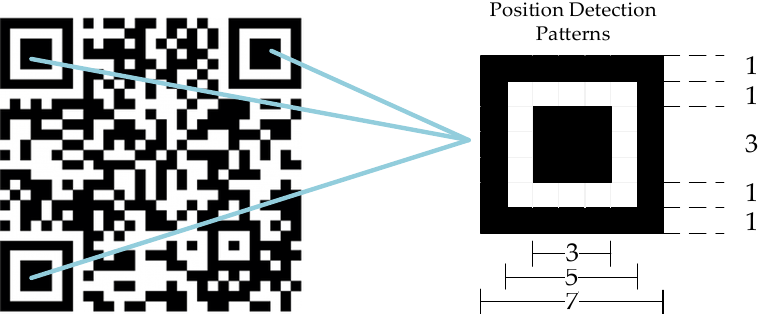
Figure 2. Position detection patterns in QR